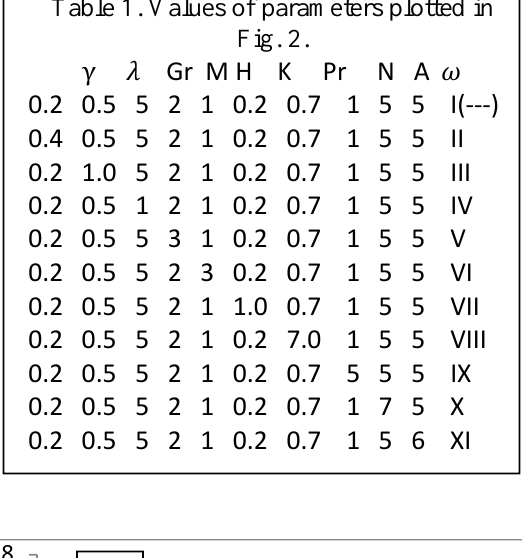
Table 1. Values of parameters plotted in Fig. 2.